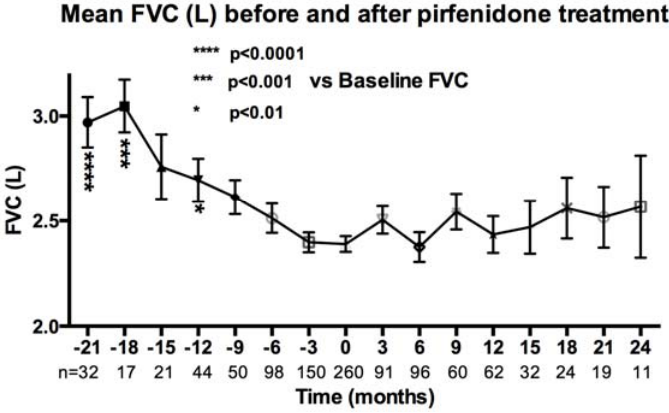
Figure 4. Reduction in decline of mean FVC before and after pirfenidone treatment.